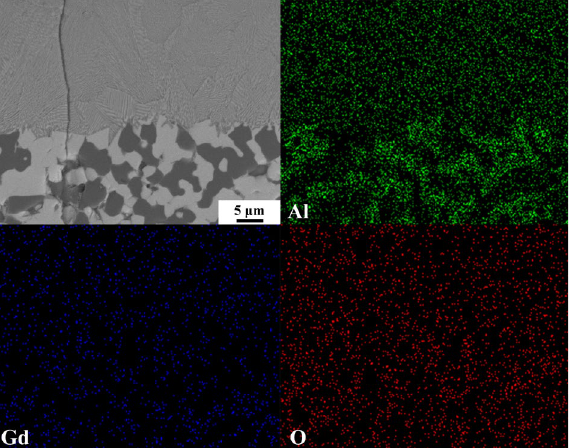
Figure 8. Cross-sectional morphologies of the vitrification area of Al 2 O 3 -GAP layer and the corre- sponding EDS mapping results of Al, Gd, and O elements.